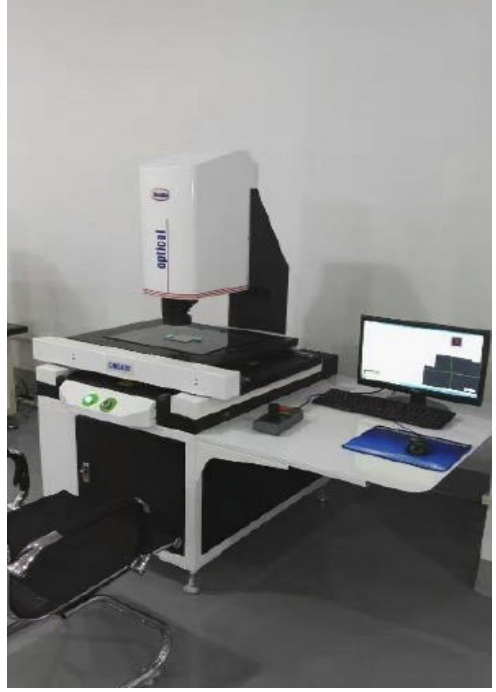
Figure 9. Tire cross-section scanner.